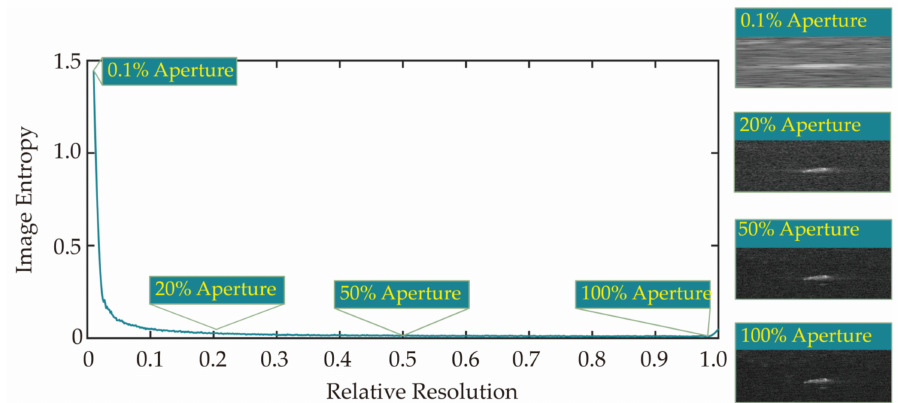
Figure 11. Change of image entropy with the azimuth resolution.